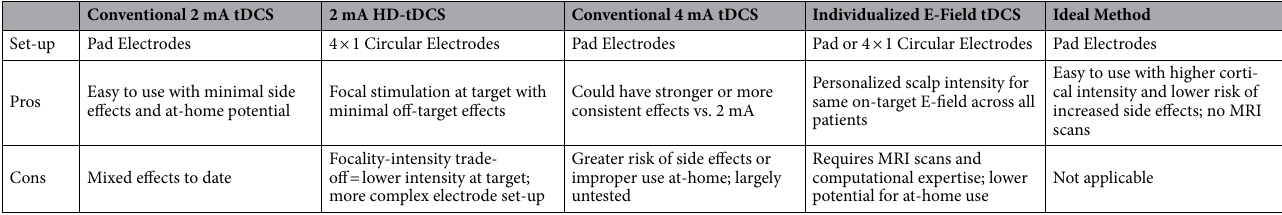
Table 1. Pros and Cons of Different tDCS Stimulation